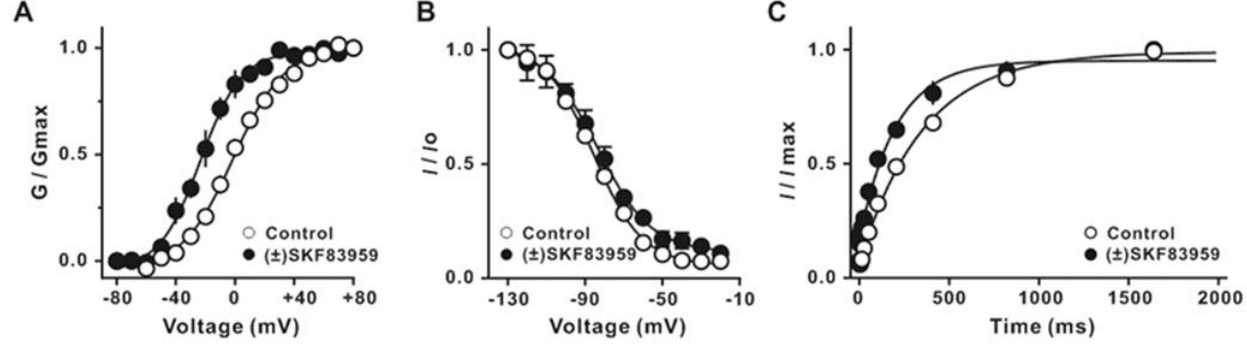
Figure 7. Effects of ( 6 ) SKF83959 on the activation and steady-state inactivation of the delayed rectifier K + current in rat hippocampal neurons. (A) Activation curves of the delayed rectifier K + current ( I K ) prior to and during superfusion with 100 m M ( 6 ) SKF83959 (n=8). (B) Steady-state inactivation curves of I K prior to and during superfusion with 100 m M ( 6 ) SKF83959 (n=8). (C) Time courses of recovery of I K from inactivation prior to and during superfusion with 100 m M ( 6 ) SKF83959 (n=6). For studying the activation, neurons were held at 2 50 mV, currents were elicited with a series of 400-ms step from 2 80 mV to + 80 mV in 10 mV increments following a 600-ms hyperpolarizing prepulse to 2 110 mV and a 50-ms interval at 2 50 mV, delivered every 10 s. For studying the steady-state inactivation, neurons were held at 0 mV, currents were elicited with a series of 600-ms prepulses at different hyperpolarizing potentials followed by a 50-ms interval at 2 50 mV and a 400-ms step to + 40 mV, then back to 0 mV, delivered every 10 s. For studying the time course of recovery from inactivation, neurons were held at 0 mV, currents were elicited on return from hyperpolarizing prepulses of varying durations at 2 110 mV to + 40 mV, delivered every 10 s.